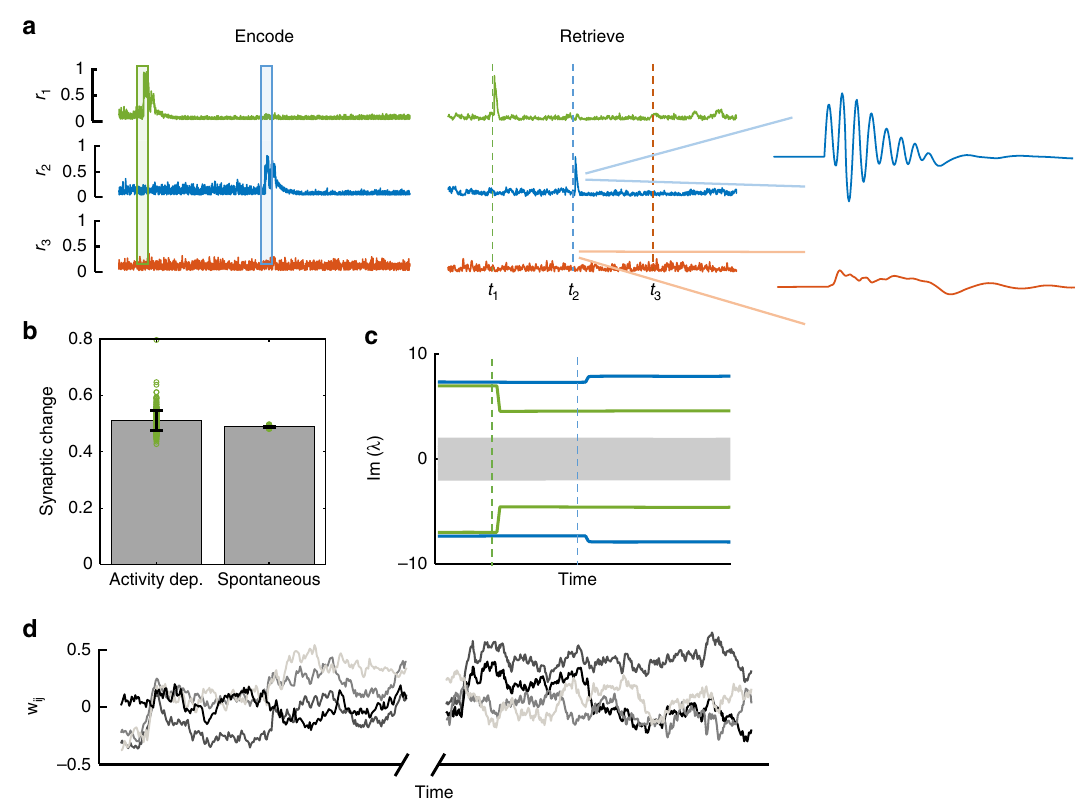
Fig. 5 Stable memory with unstable synapses. a Left: Learning phase. Two distinct stimuli are sequentially presented to the network (green and blue shaded areas). Right: Retrieval phase. The embedded memories are read out of the network dynamics via a brief stimulation bearing partial information of the original stimulus. Overlaps of the network state x with the two learned planes are shown in corresponding color. During retrieval, activity follows the oscillatory trajectory of the dynamic memory item (blue zoom). A novel cue, on the other hand, does not elicit a signi fi cant response in neural activity (bottom trajectory, orange). b Relative contributions of activity-dependent (left bar) and spontaneous (right bar) synaptic fl uctuations are estimated to be of similar magnitude during all phases of the memory life-cycle (see “ Methods ” ). Error bars denote one standard deviation from the mean; overlaid data points are marked by green circles. c Effect of retrieval on existing memories can differ, with the green memory degrading, and the blue one strengthening. d Weights of four out of N 2 synapses (gray shades) as a function of time. The spontaneous and homeostatic contributions to plasticity drive perpetual fl uctuations of synaptic weights, which occur during and after learning. This fi gure shows results for the rate-control homeostasis rule ( N = 128, see “ Methods ”